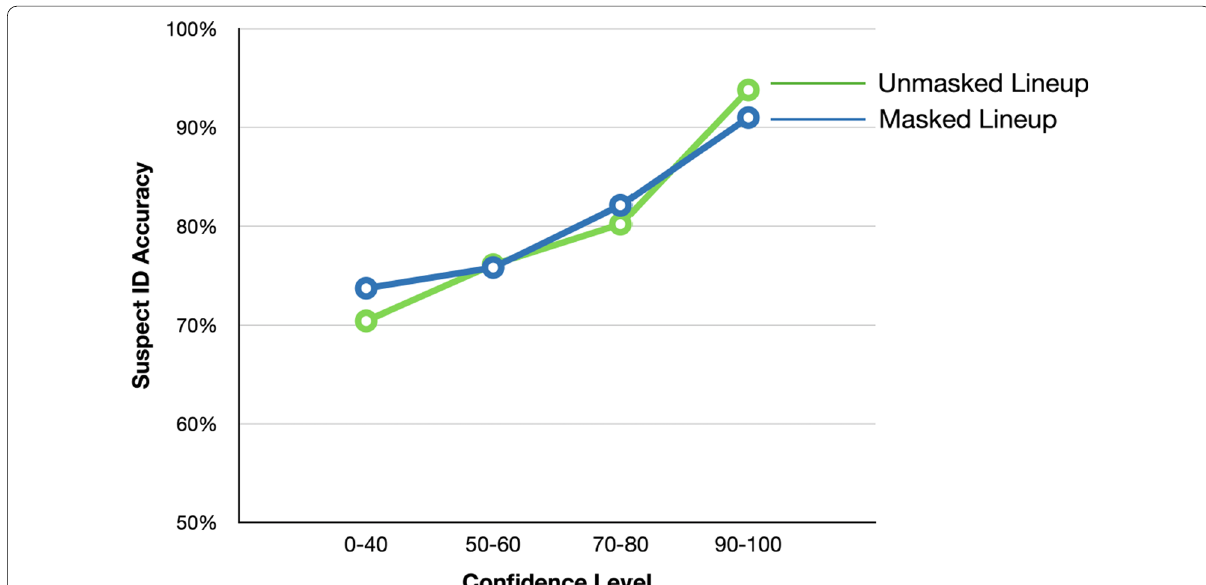
Fig. 3 Confidence-Accuracy Characteristics (CAC) curves for the masked and unmasked lineups in Experiment 1. The y-axis starts at 50%. Note that the values that contribute to a CAC curve are proportions from the whole sample and so CAC curves do not have error